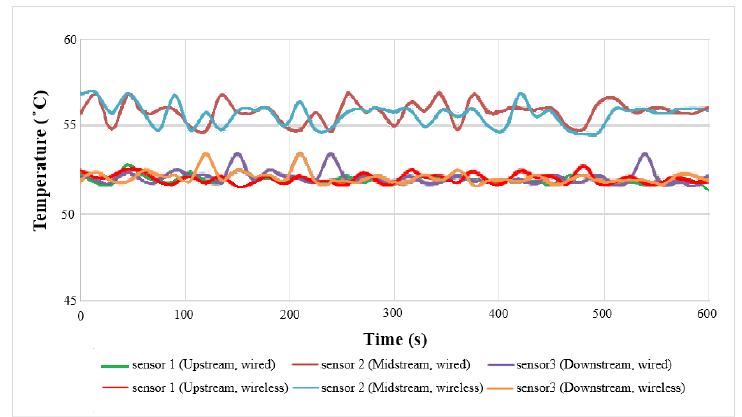
Figure 10. Local temperature distributions of wired and wireless sensors.